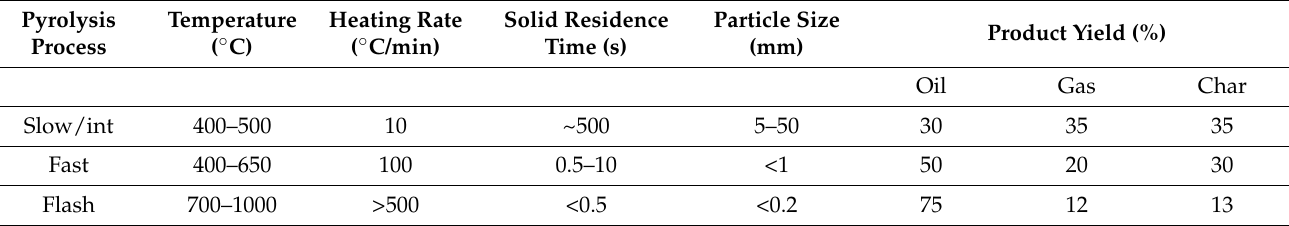
Table 1. Classification of pyrolysis process